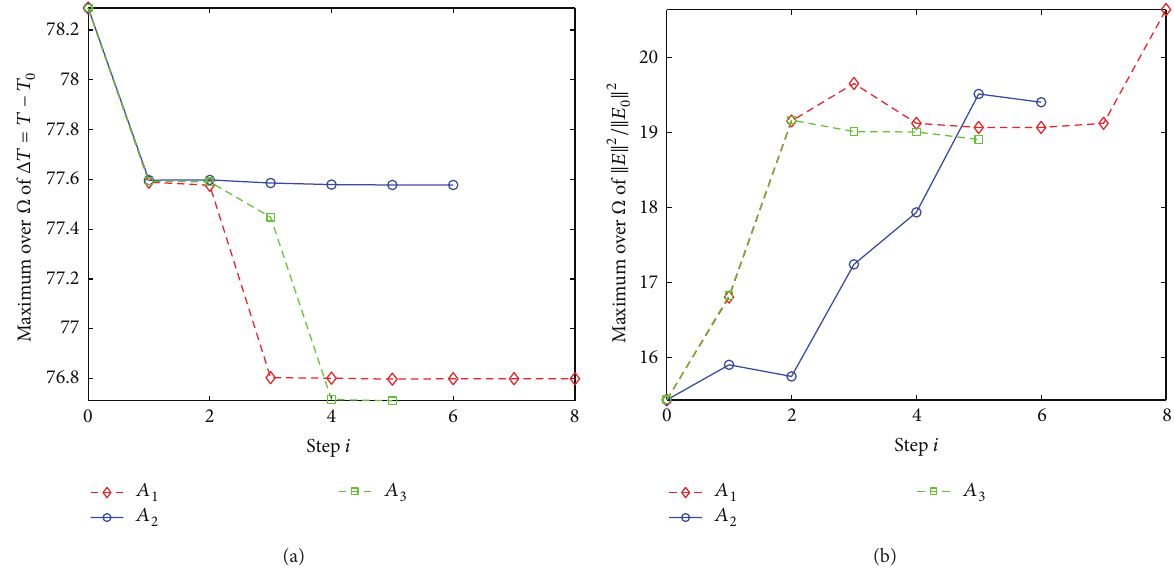
Figure 2: Evolution of the relative maximum of the temperature max Ω (𝑇 − 𝑇 0 ) (a) and of the intensity of electric field max Ω ‖ E ‖ 2 /‖ E 0 ‖ 2 (b), using the adaptive remeshing method and strategies 𝐴 1 , 𝐴 2 , and 𝐴 3